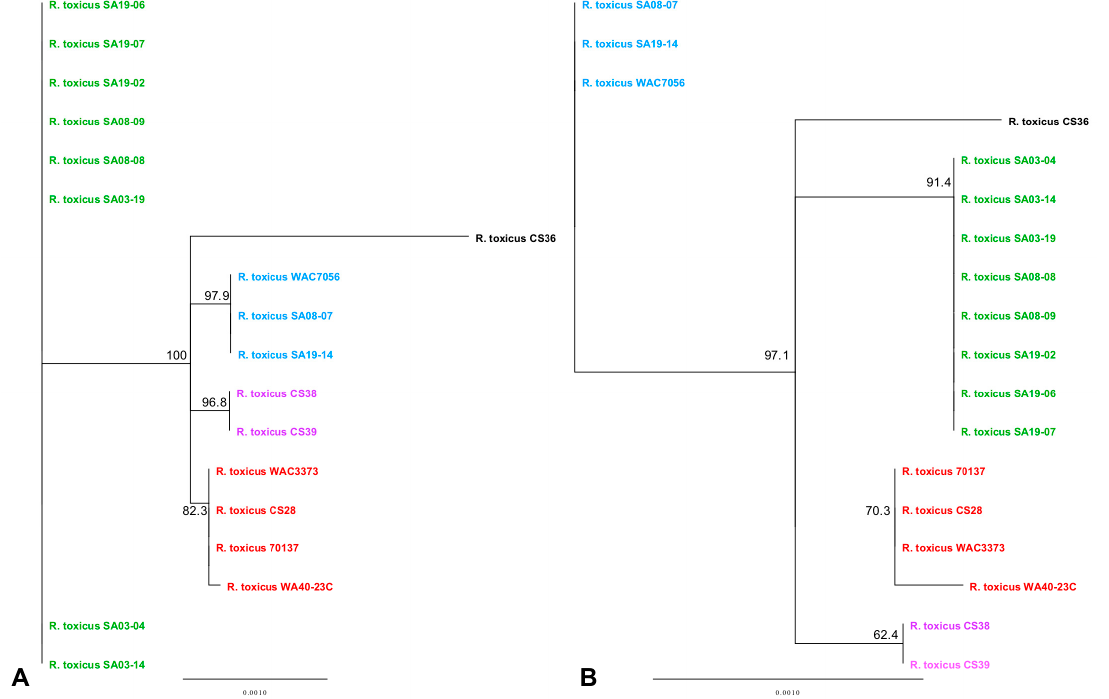
Figure 7. Multi ‐ locus sequence analysis of R. toxicus isolates used in this study. Neighbor ‐ joining trees were based on concatenated ( A ) DNA and ( B ) amino acid sequences of six genes ( atpD , dnaK , gyrB , ppK , recA and rpoB ) from 18 R. toxicus isolates and calculated using the Jukes ‐ Cantor method to compute evolutionary distances. Confidence intervals were assessed using the bootstrap method with 1000 replications. Strains within the phylogenetic tree are color ‐ coded based on the genetic population. Green: RT ‐ I; blue: RT ‐ II; red: RT ‐ III; black: RT ‐ IV; purple: RT ‐ V.